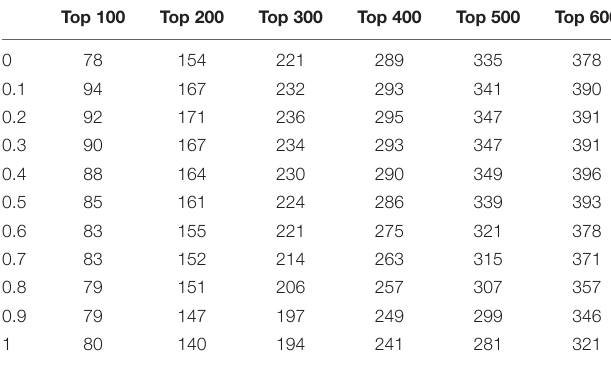
TABLE 1 | The impact of parameter α to the performance of